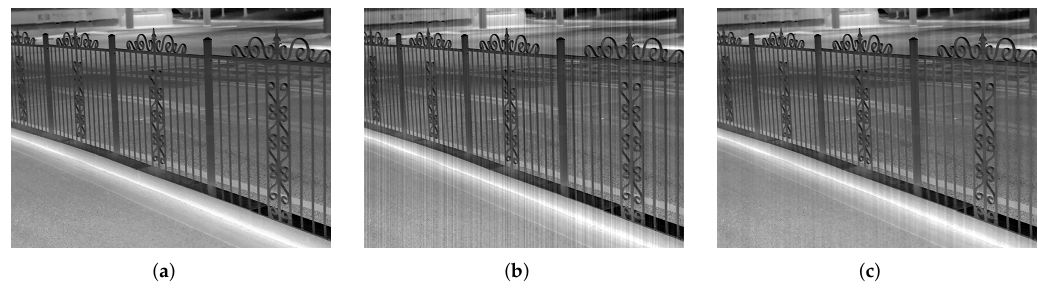
Figure 17. Filtered result for Fence ( a ) Clean; ( b ) Noisy; ( c )